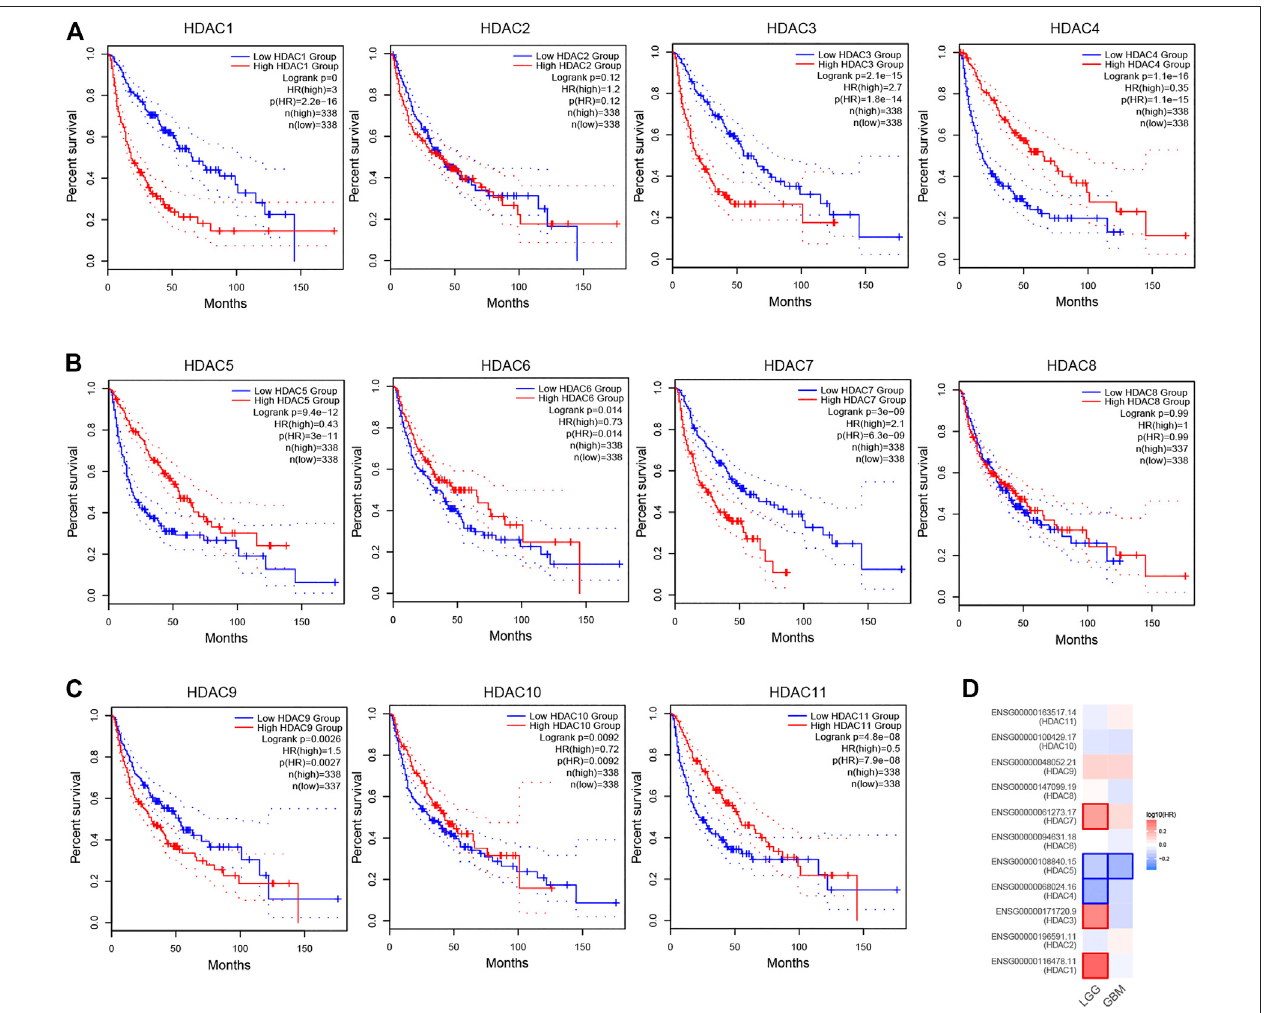
FIGURE 7 | Prognostic value (DFS) of HDAC family in glioma based on GEPIA. (A – C) The KM survival curves revealed contrasting survival possibility predicted by varyingexpressionofHDACfamily. (D) TheheatmapwasusedfordetectingtherelationsbetweentheHDACfamilymembers ’ expressionandtheDFSofLGGandGBM